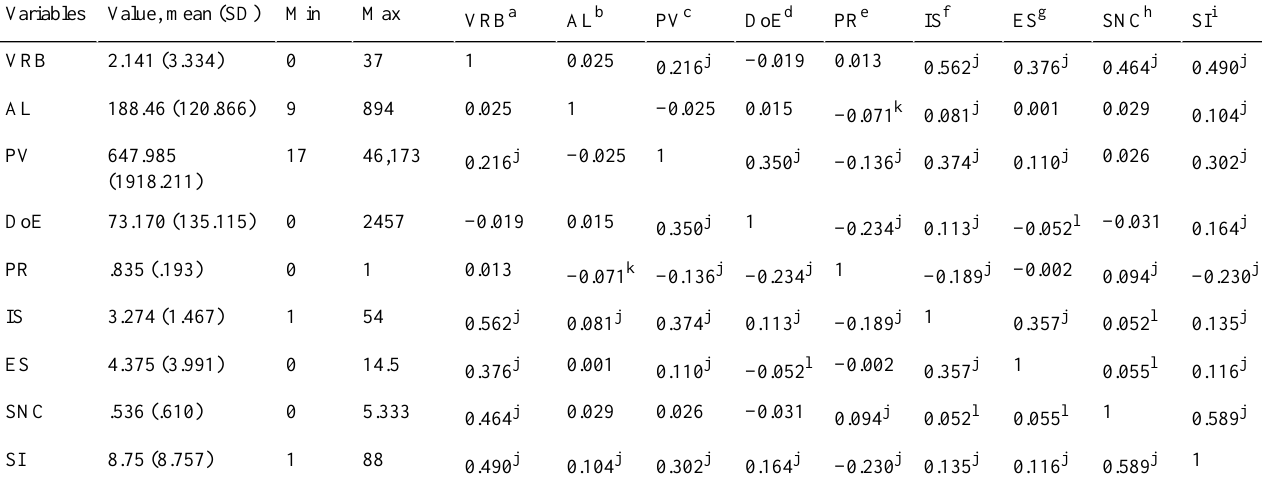
Table 3. Results of descriptive statistics and the covariance